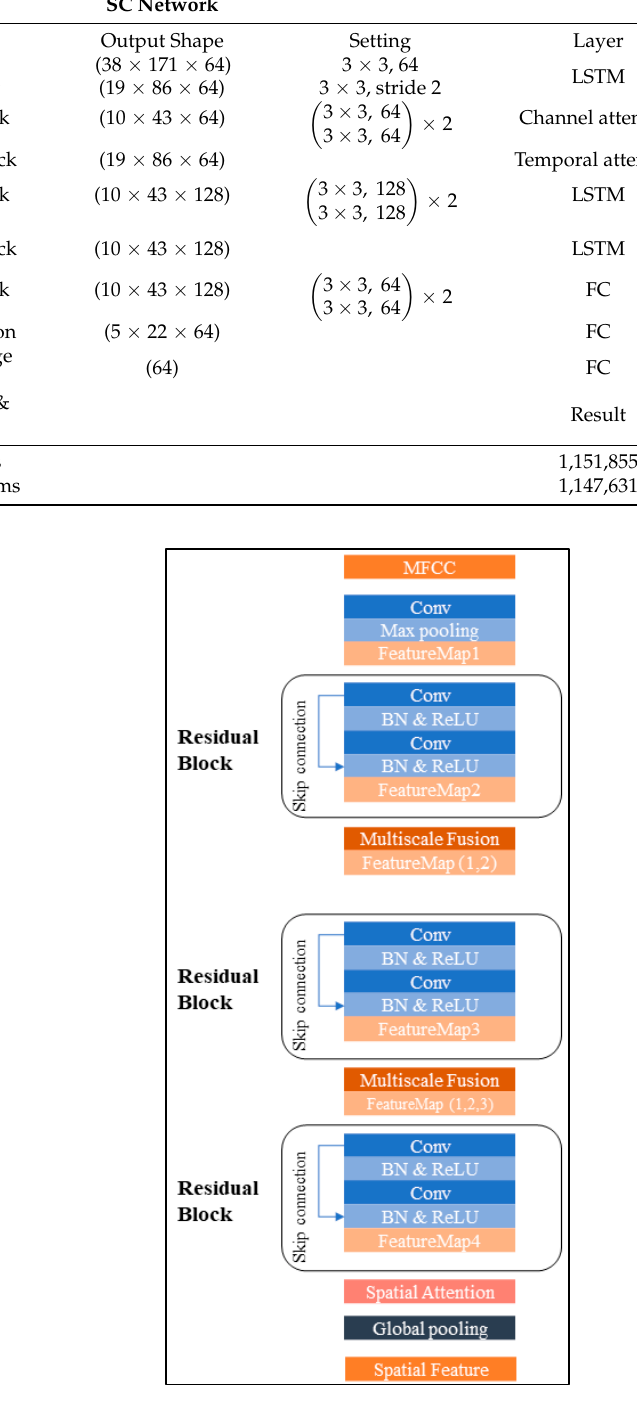
Figure 4. Network design of the proposed residual block.